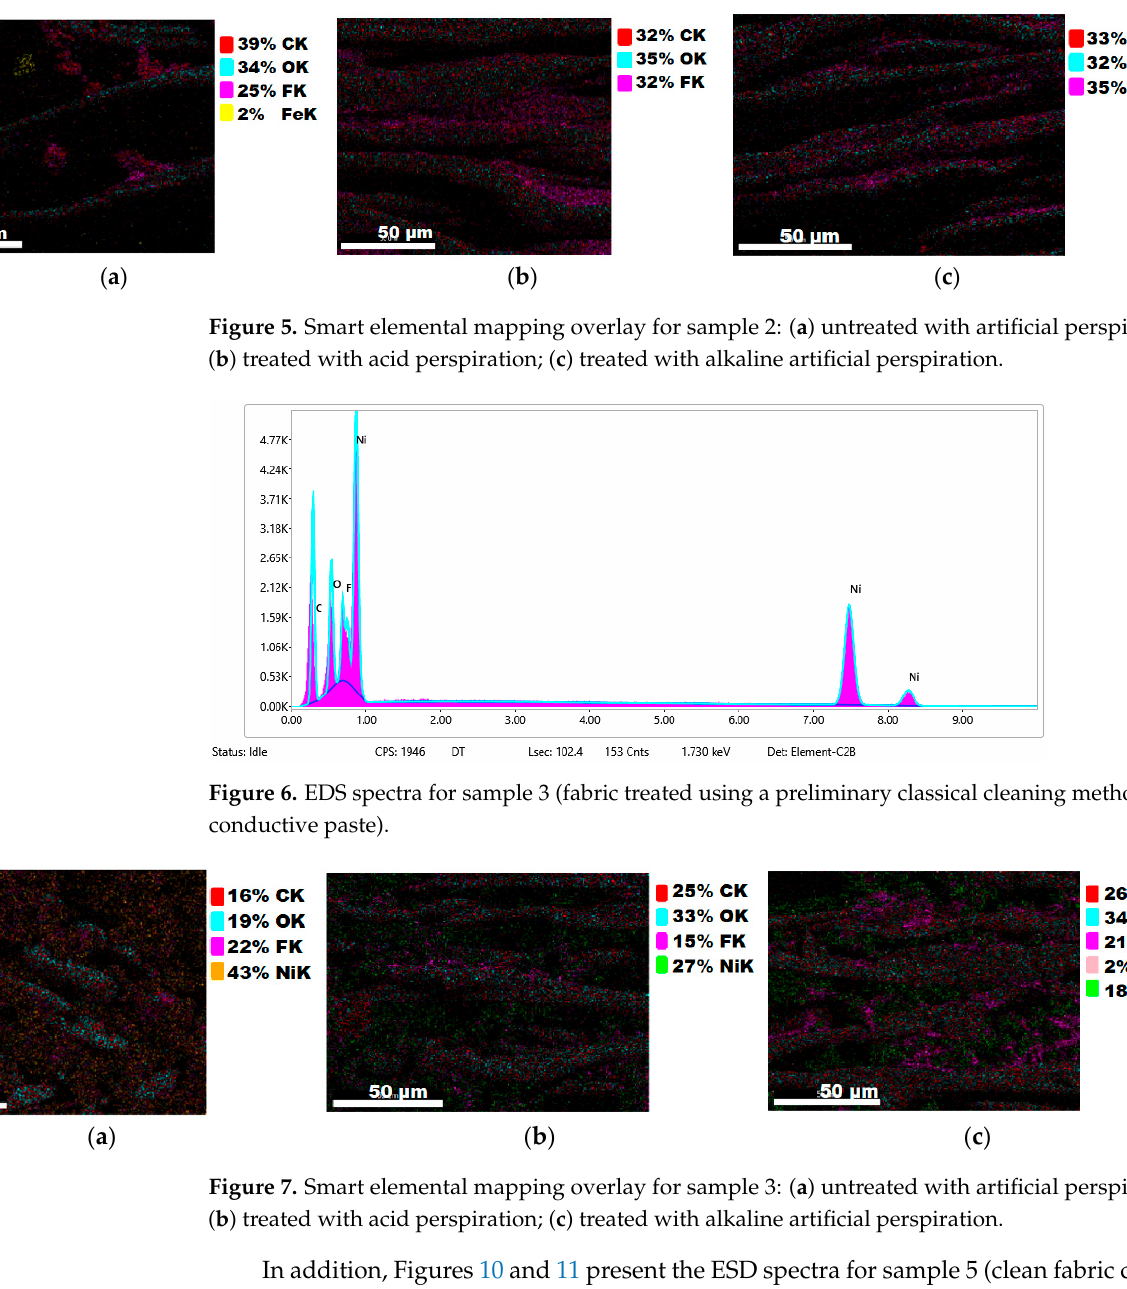
Figure 4. EDS spectra for sample 2 (fabric treated using a preliminary classical cleaning method and